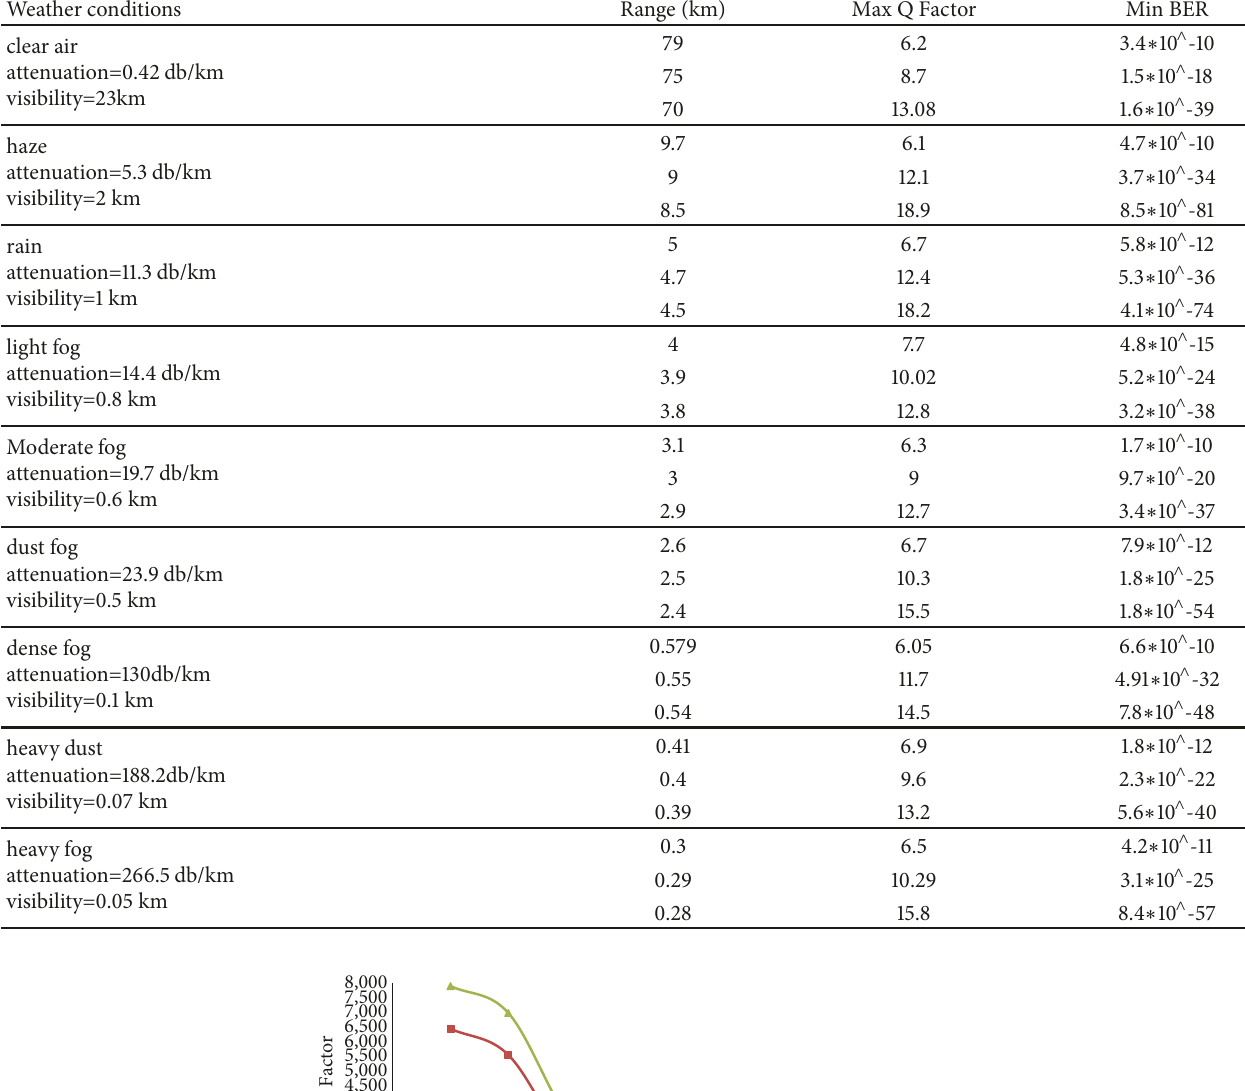
Table 6: Results for 1T X /1R X FSO at different weather conditions for 850 nm wavelength.